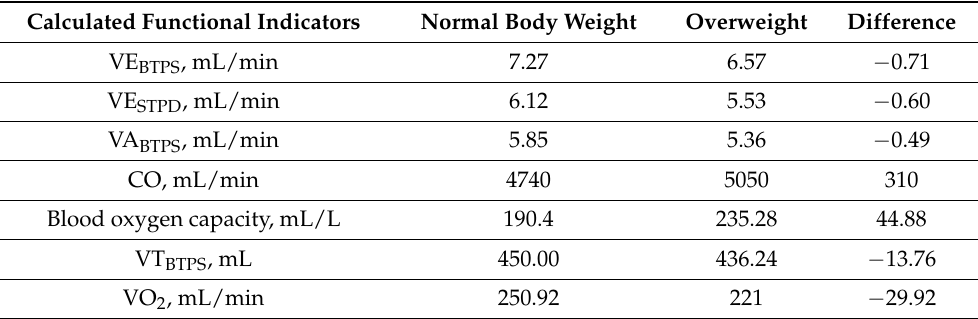
Table 3. Calculated functional indicators of the functional respiratory system state in the same person at normal body weight and overweight.